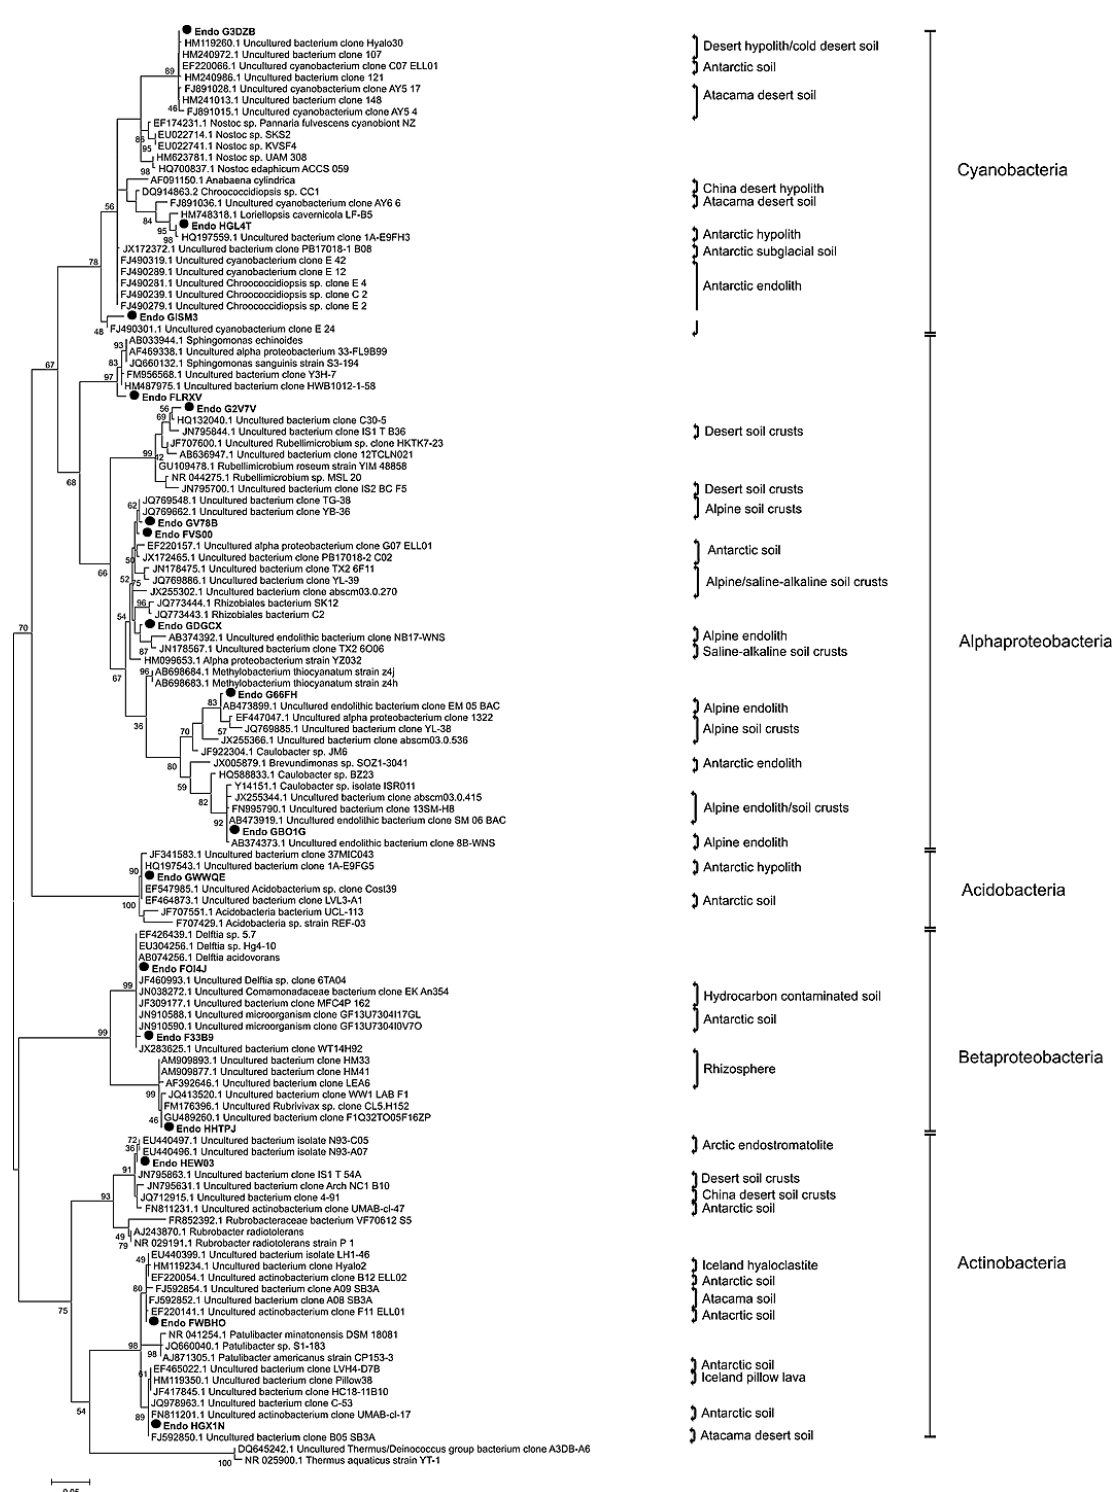
Fig. 5. Maximum likelihood (ML) phylogenetic tree illustrating the inferred relationship between 16S rRNA gene sequences (527bp) show- ing the position of dominant bacterial members of the endolithic community ( • bold) related to the most similar GenBank sequences. Taxa isolated from other extreme and/or endolithic environments are described. Bootstrap values (expressed as percentages of 500 replications) are shown at branch nodes. Similar topologies were recovered in trees generated with the neighbor-joining algorithm. Bar: 0.05 substitutions per nucleotide